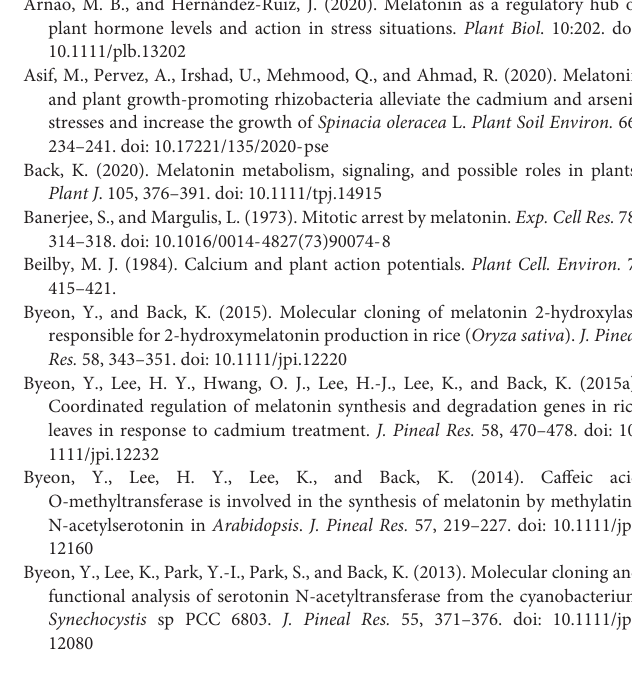
(c) all original research articles. Supplementary Figure 3 | Top papers included in DOI network (in degree cut-off of 100) with numbers in table corresponding to node numbering also displayed in Figure 10 . Supplementary File 1 | Summary of methods used for literature